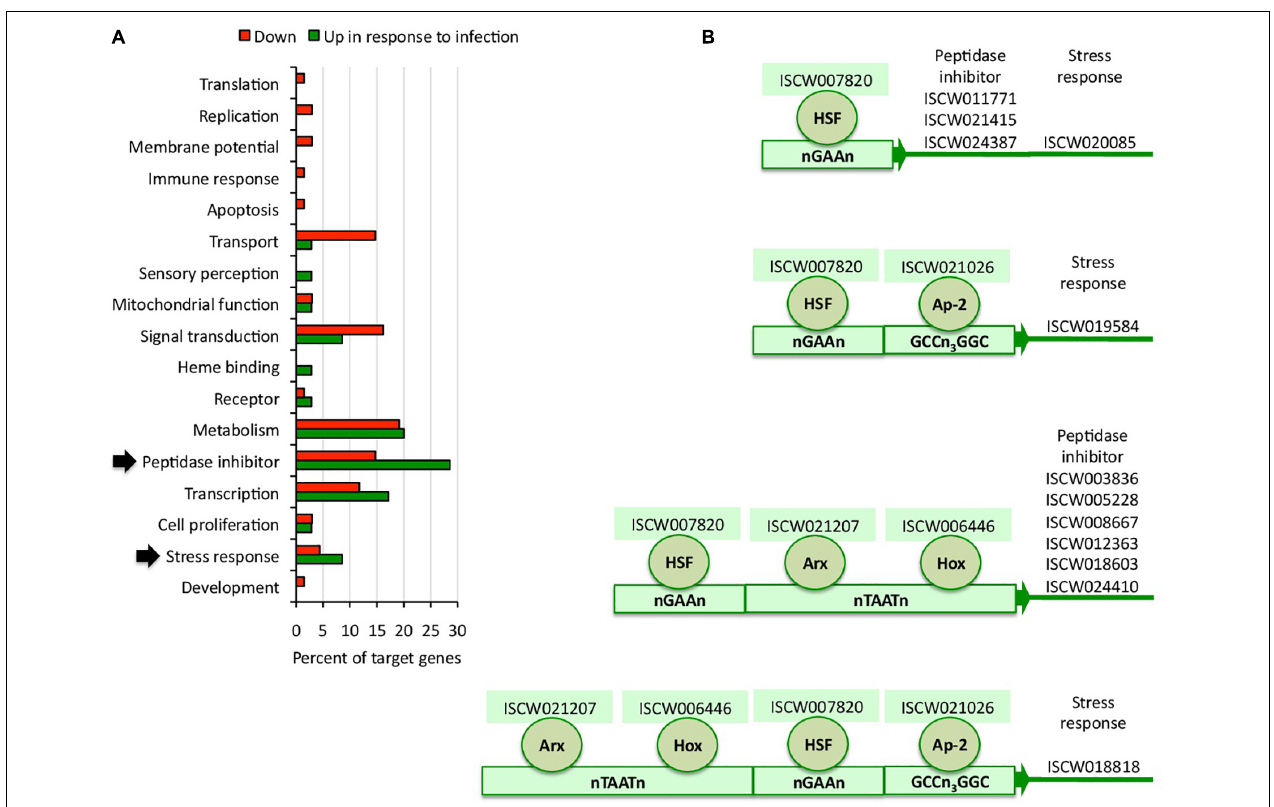
FIGURE 3 | Biological processes affected by the tick ISE6 cells regulome in response to A. phagocytophilum infection. (A) Upregulated and downregulated target genes in the in silico predicted tick ISE6 cells regulome in response to A. phagocytophilum infection were grouped according to their BP. The BP with higher representation in the upregulated than in downregulated regulome in response to infection (arrows) were selected for characterization of TF-TG interactions. (B) Predicted regulatory DNA motifs according to regulatory factors identified by RNAseq in infected cells only and involved in the control of upregulated target genes annotated in the peptidase inhibitor and stress response BP with higher representation in the upregulated than in downregulated regulome.